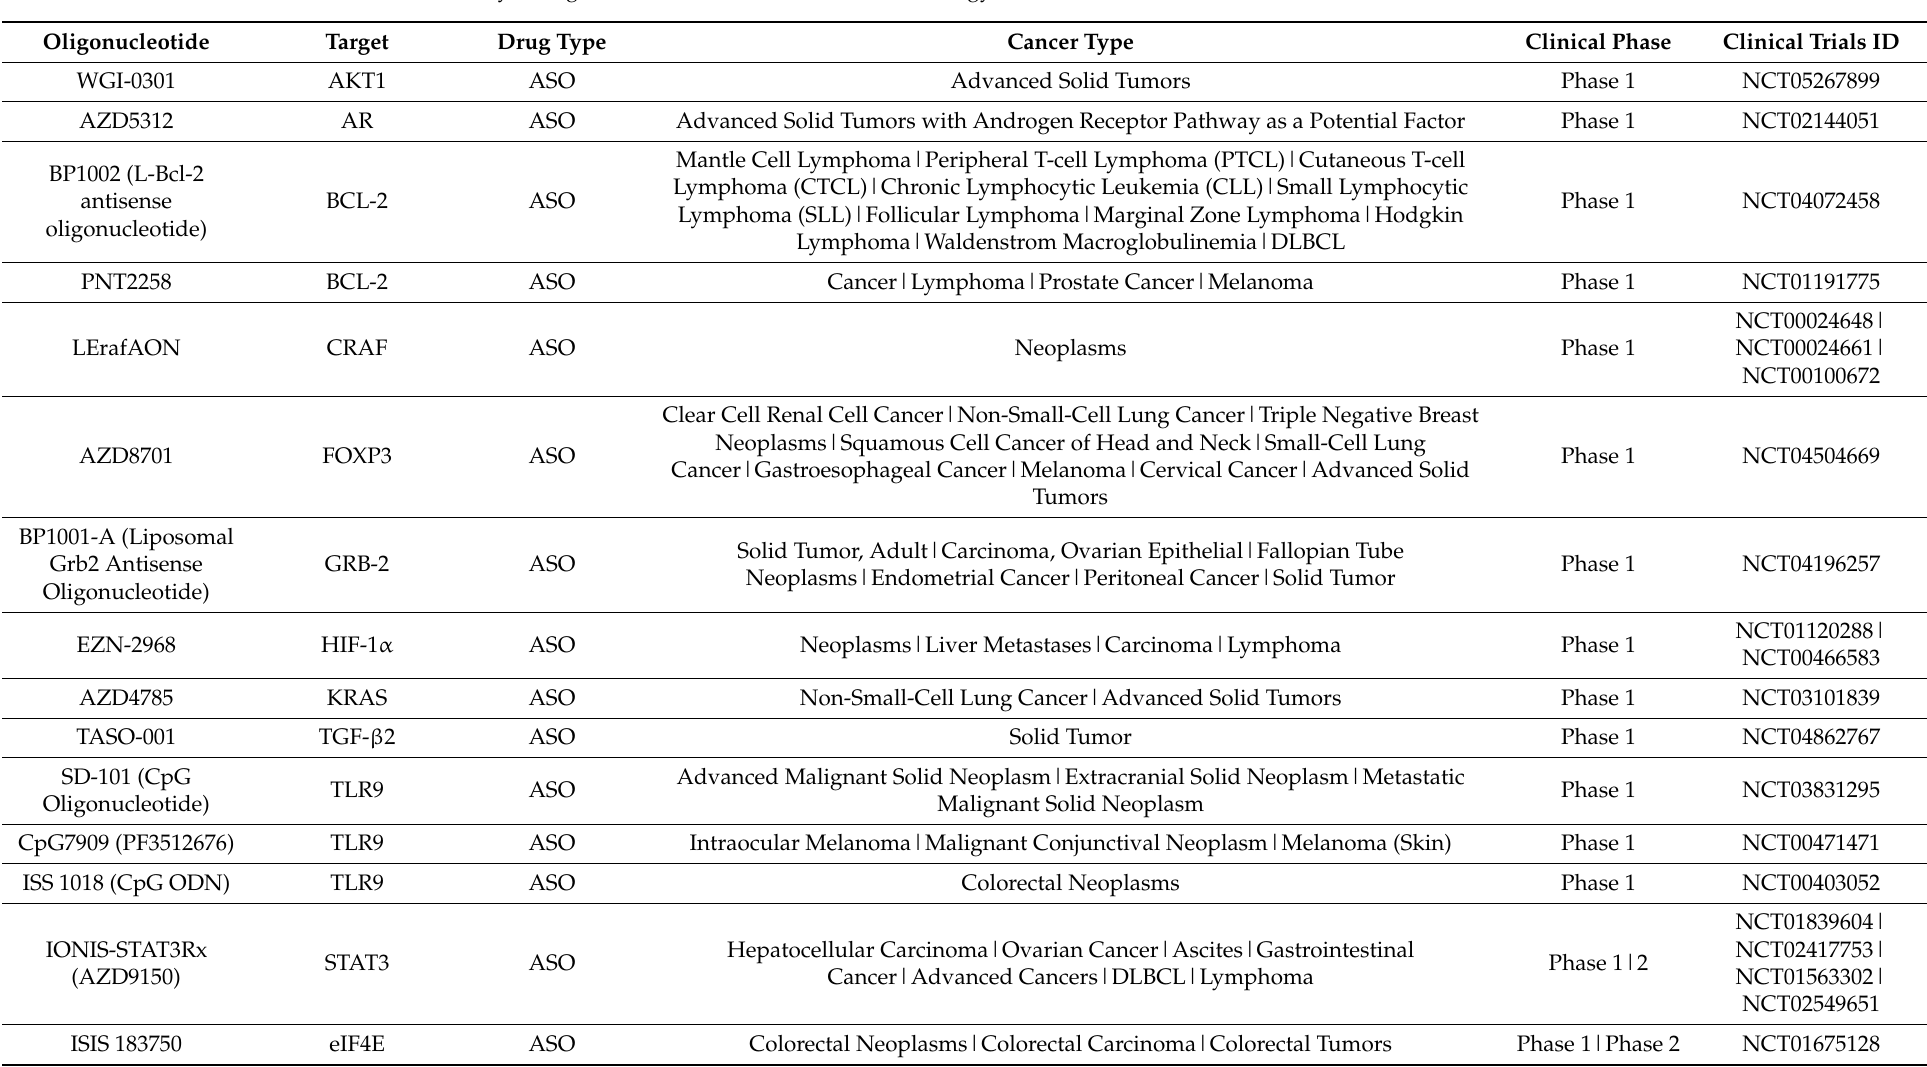
Table 1. Summary of oligonucleotides in clinical trials for